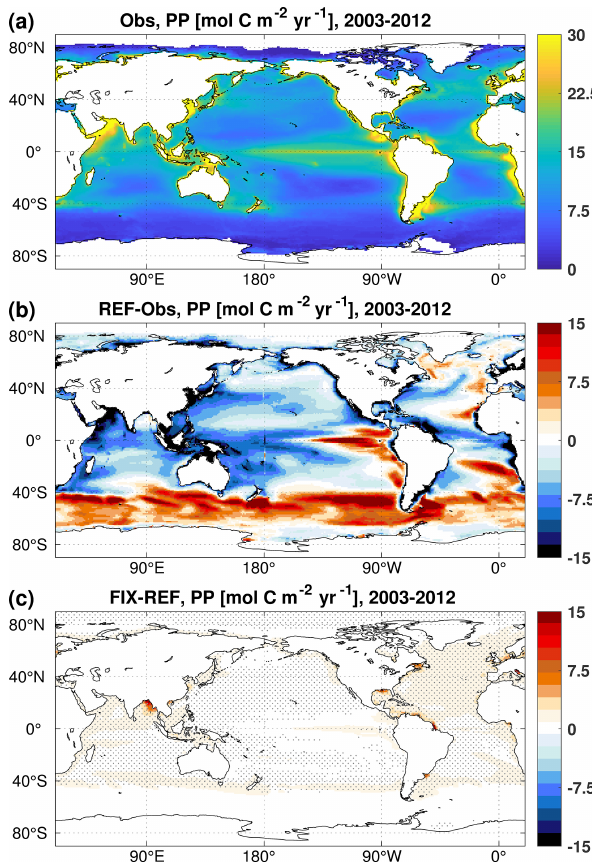
Figure 3. Vertically integrated primary production averaged over the 2003–2012 period of (a) the mean of three satellite-based clima- tologies derived from MODIS retrievals, (b) the difference between REF and satellite-based estimates, and (c) the difference between FIX and REF. In panel (c) , only significant differences are plotted, and dots denote areas where the signal is larger than the standard deviation of the absolute field (see details in Appendix